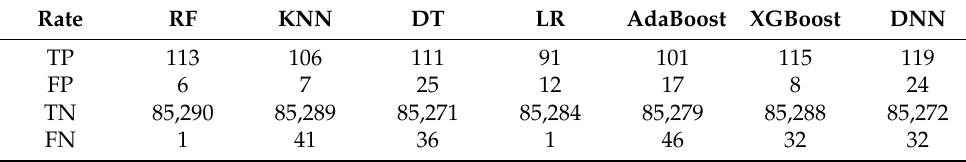
Table 5. TP, FP, TN, FN rates of machine learning algorithms on imbalanced dataset.